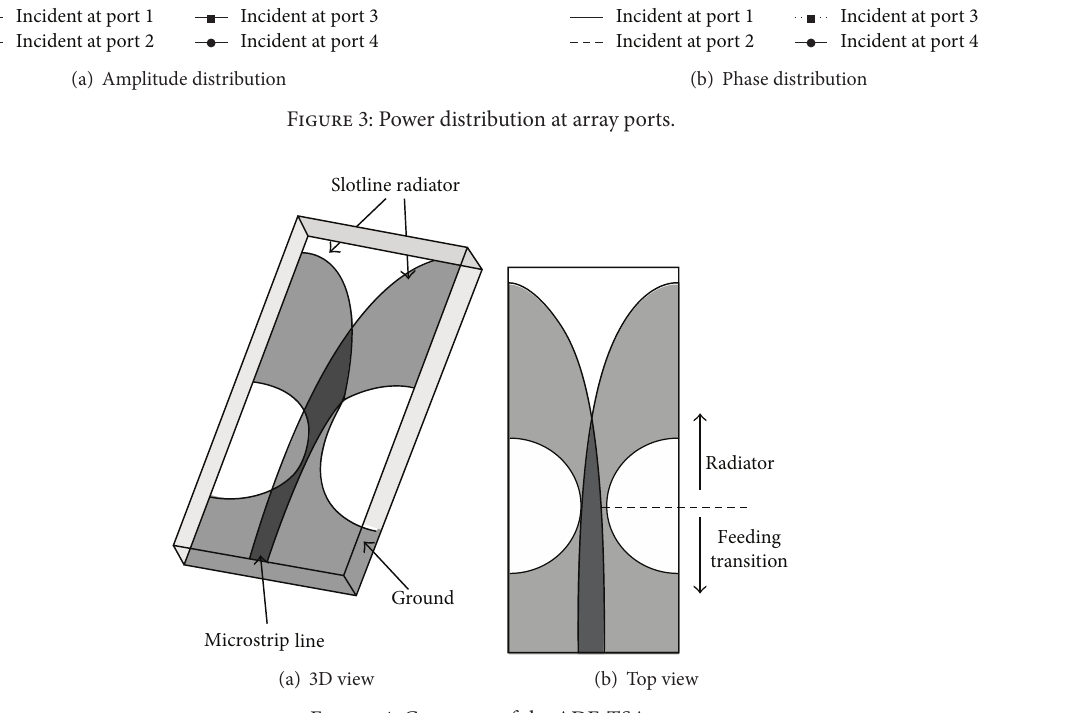
Figure 4: Geometry of the